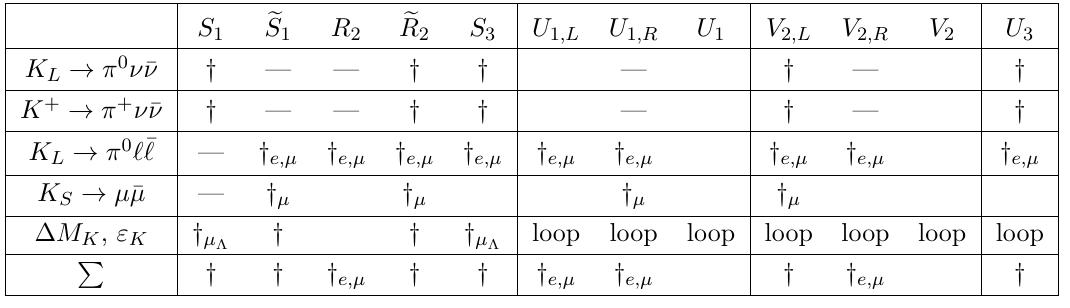
Table 3. Overview of strong con(cid:13)icts with current bounds/measurements on rare Kaon processes when requiring ( " 0 =" ) NP = (cid:20) " 0 (cid:2) 10 (cid:0) 3 with (cid:20) " 0 & 0 : 5 for scalar and vector LQ models. In vector LQ models only the EW gauge-mixing is included in " 0 =" , see main text for details. The symbols in the table correspond to: \|" = no contributions in this LQ model; \loop" = mediated by loop corrections in vector LQ models; \ y " = ruled out for all lepton (cid:13)avours ‘ = e; (cid:22); (cid:28) ; \ y ‘ " = ruled out for lepton (cid:13)avour ‘ ; \ y (cid:22) " = ruled out for all lepton (cid:13)avour if LQ mass is large (cid:3)